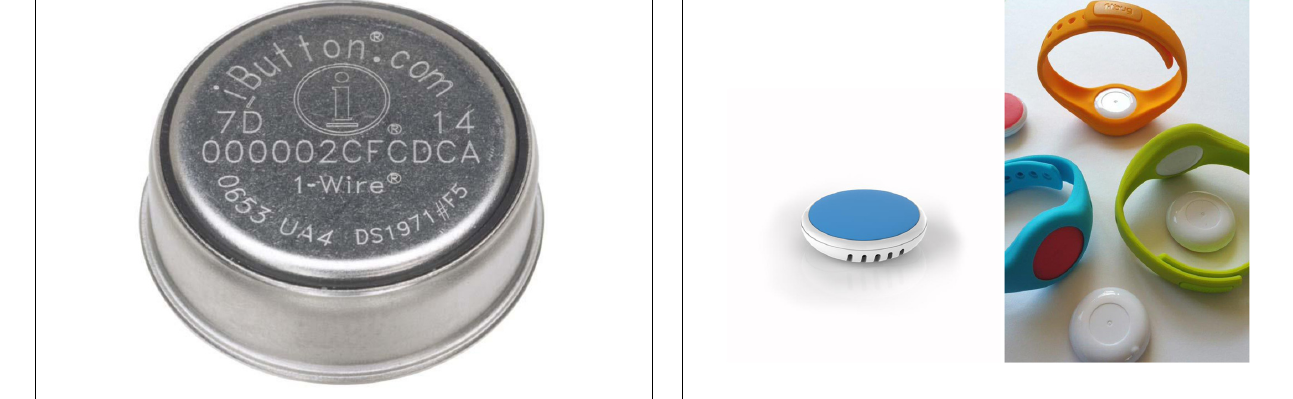
FIGURE 1 | Maxim’s “Thermochron iButton DS1291H.”